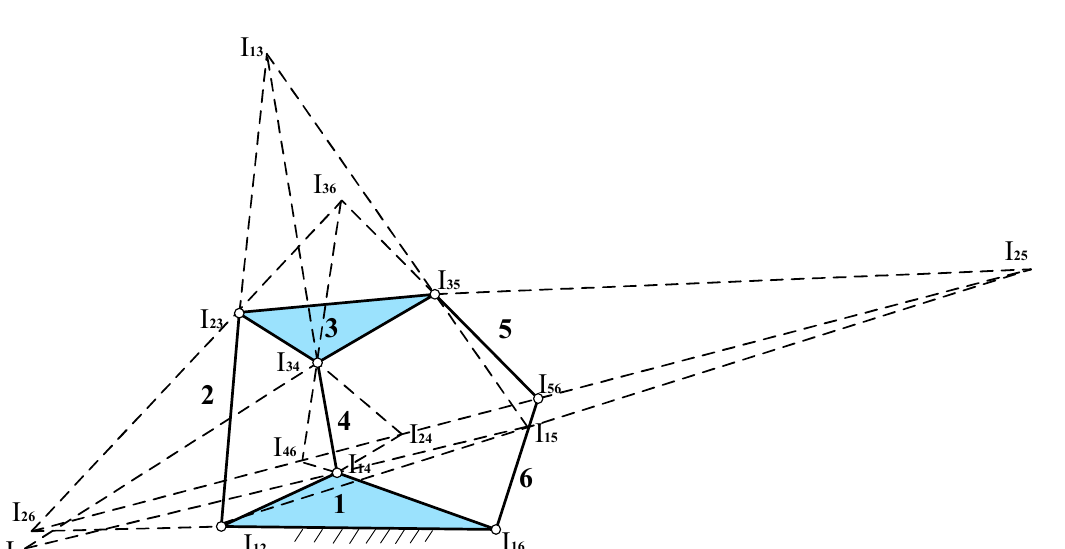
Figure 4. The instant center identification process graph of the Stephenson linkage. 3.1.1. Coupled Loop Chain Characteristic